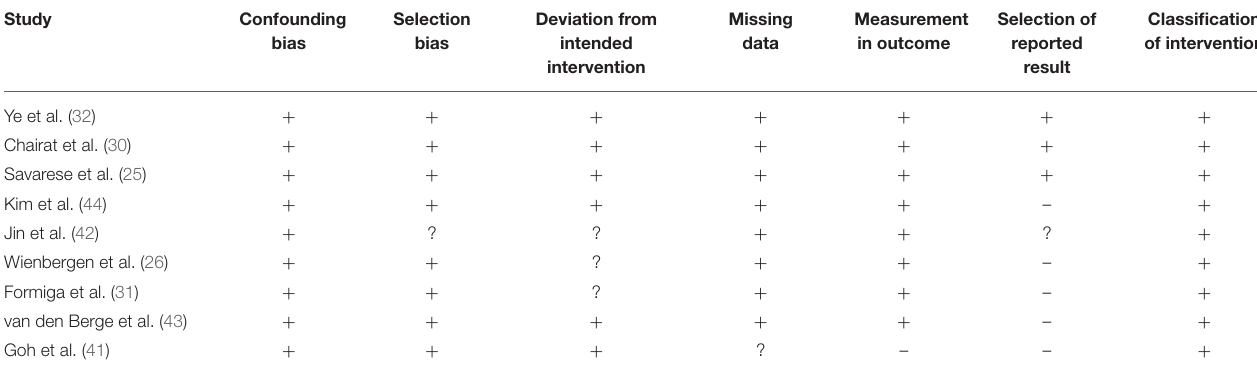
TABLE 3 | Risk of bias within studies according to the ROBINS-I scale.